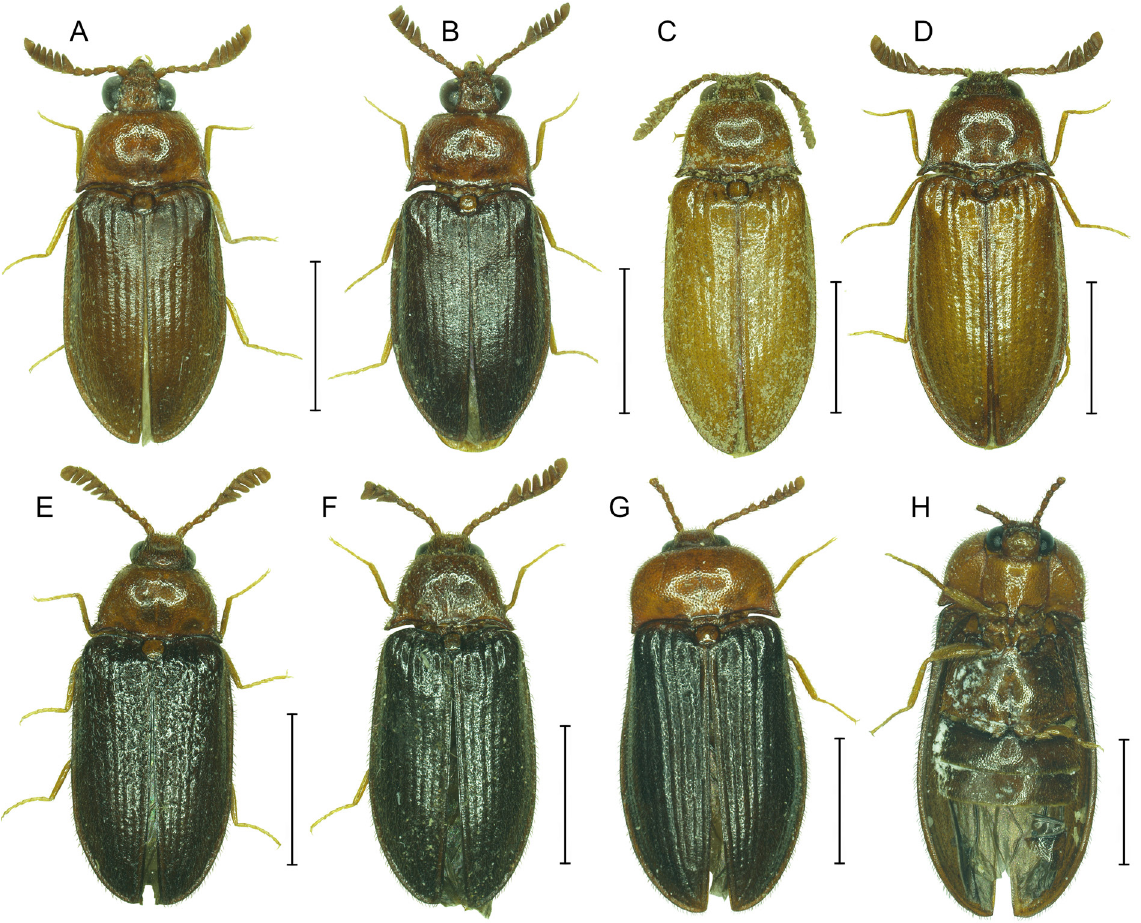
Fig. 1. Habitus of Brachypsectra spp. in the Palaearctic Region. A–D . ♂♂ of B. kadleci Hájek, 2010, Iran. A . Holotype, Lorestan. B . Non-type specimen from Lorestan. C . Specimen from Bezan. D . Specimen from Minab. – E–F . ♂♂ of B. jaechi sp. nov., Turkey, Kemer. E . Holotype. F . Paratype. – G–H . ♀ of Brachypsectra sp. from Cyprus. G . Dorsal view. H . Ventral view. Scale bars = 2